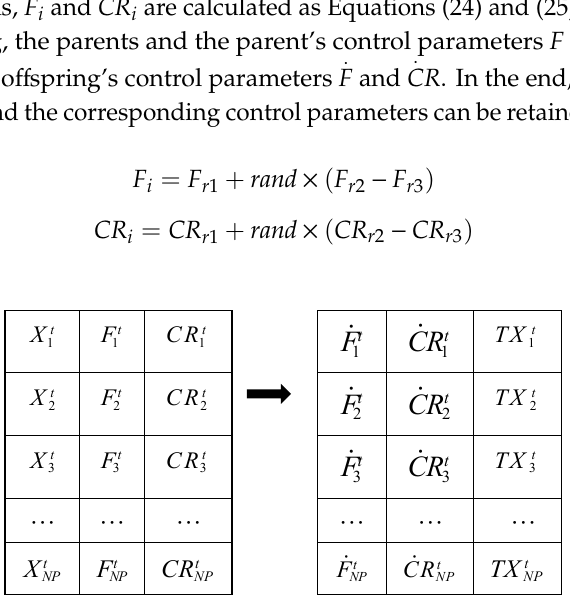
Figure 1. The individual code map.